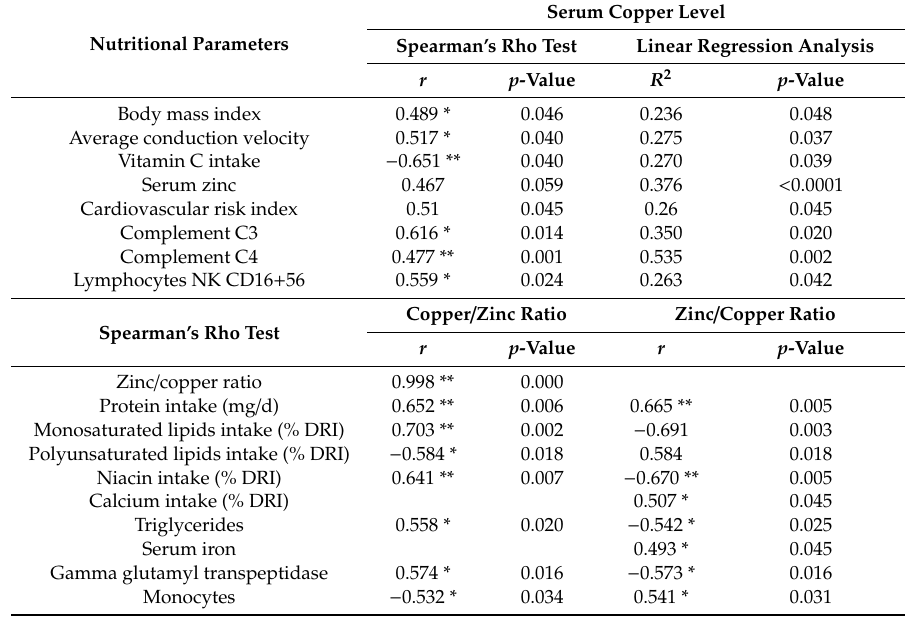
Table3. Significantcorrelationsandregressionanalysisbetweenserumcopperandnutritionalparameters.